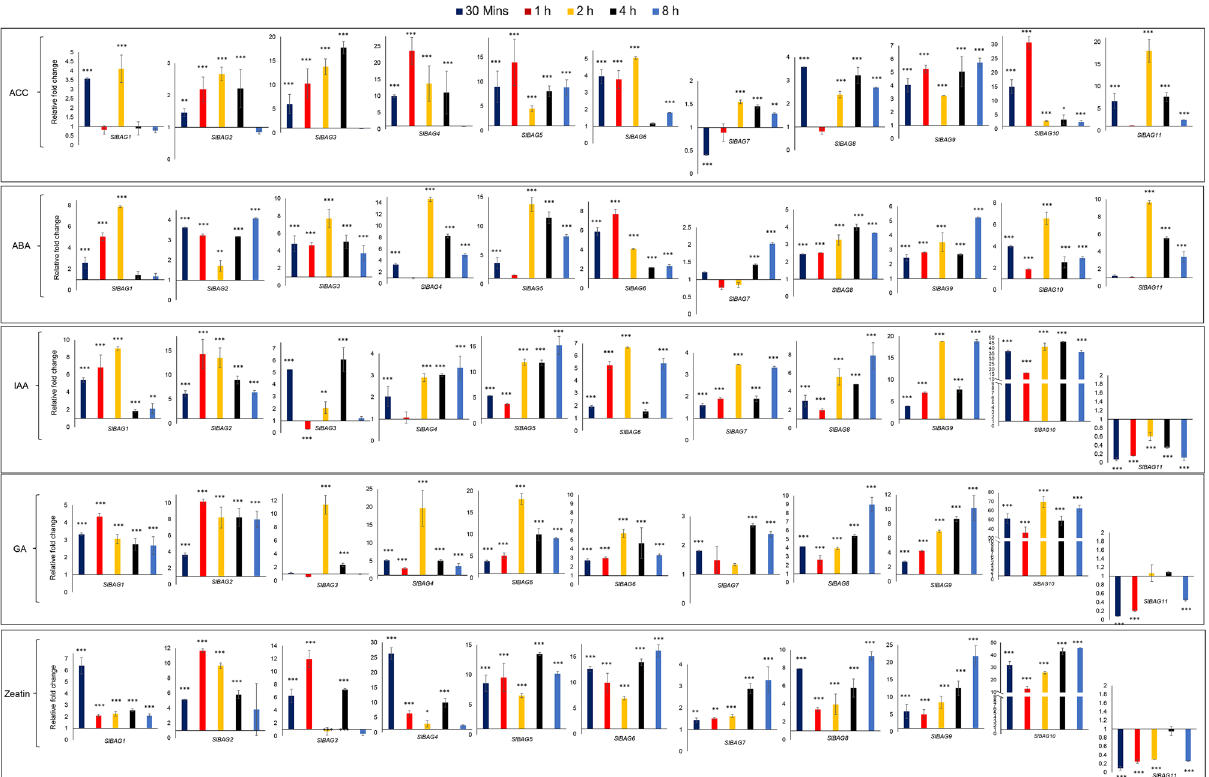
Figure 5. qRT-PCR based expression profiling of SlBAGs after hormonal treatment to tomato seedlings. Transcript accumulation in 15-d-old tomato seedlings exposed to 1 mM ACC, 0.1 mM ABA, 0.02 mM IAA, 0.02 mM GA 3 and 0.02 mM zeatin was measured by qRT-PCR using tomato actin as endogenous control by considering reference expression level 1 at 0 h time point using 2 −ΔΔCT method. All data are presented as the mean (± SE) of three independent biological determinations and analysed using Student’s t-test (*p < 0.05, **p < 0.01, ***p < are involved in the stress-induced autophagy or ubiquitin–proteasome degradation pathways 11 . Moreover, the